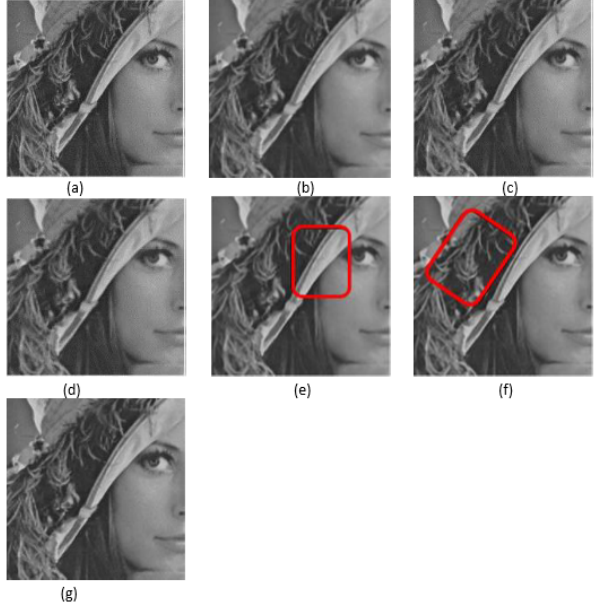
Fig. 8 Two-time reconstructed image Lena using the six SR methods. (a) Input test image. (b) FCME. (c) NARM. (d) CSFI. (e) NeedFS. (f) IUIE. (g) Our method.